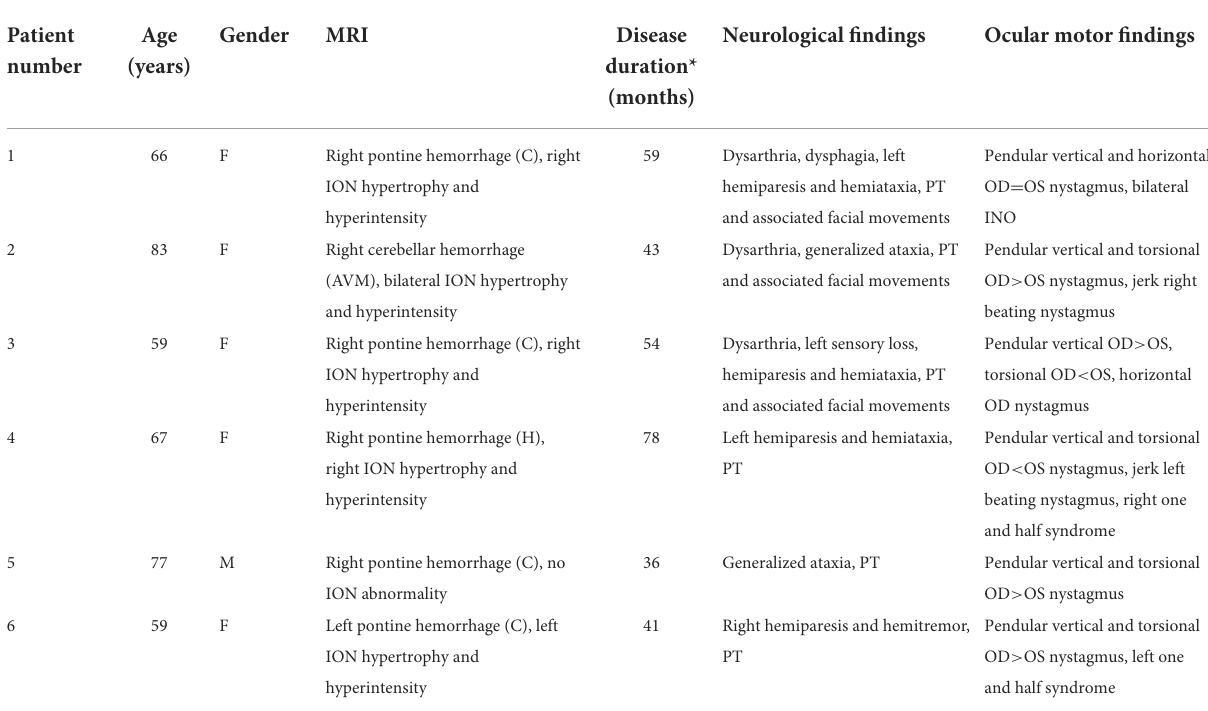
TABLE 1 Demographic and clinical